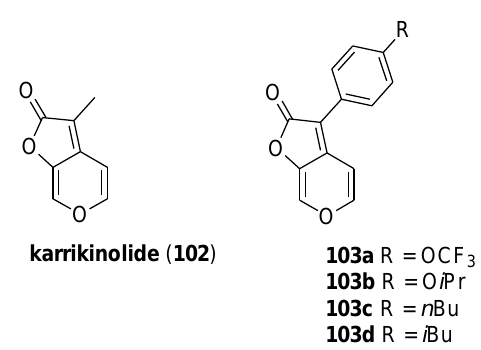
Figure 20. Karrikinolide ( 102 ) and selected derivatives 103a – d from Reference [59]. Table 11. Inhibitory effect of selected compounds on SCR, SQR, and cyt bc1.